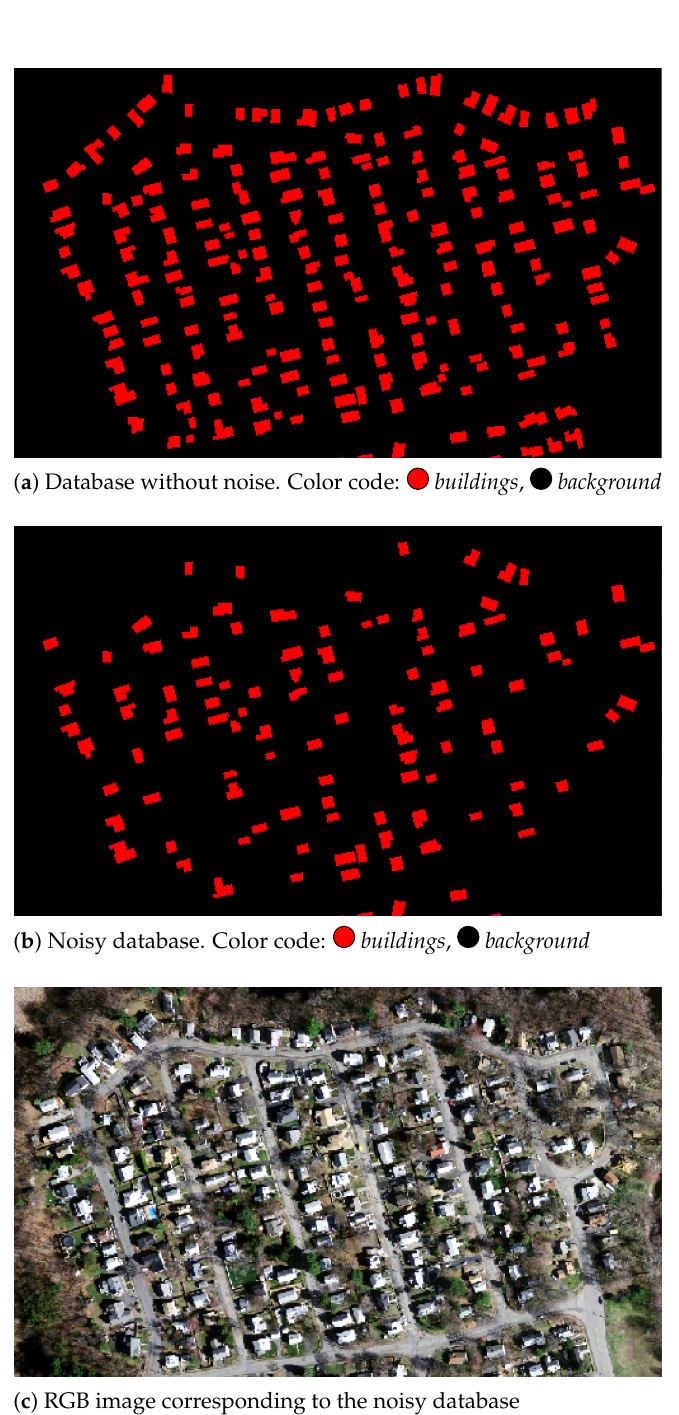
Figure 4. Illustration of label